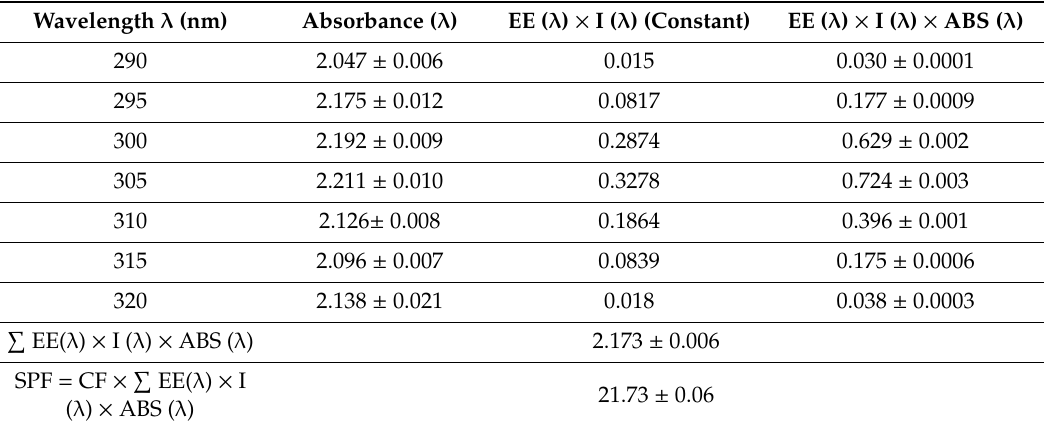
Table 1. SPF determination of 90%